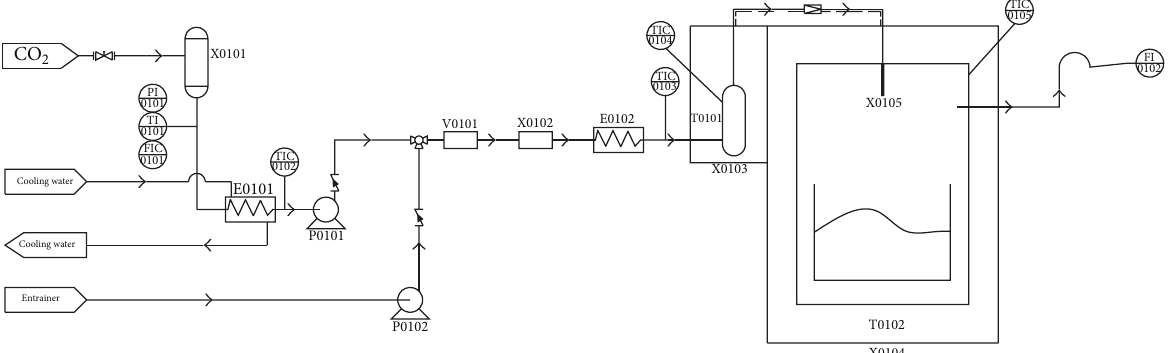
Figure 1: Process flow diagram. X0101 purifier; E0101 heat exchanger; P0101 CO 2 pump; P0102 entrainer pump; V0101 mixer; X0102 purifier; E0102 heat exchanger; X0103 incubator; X0104 incubator; T0101 extraction oven; T0102 expansion oven; X0105